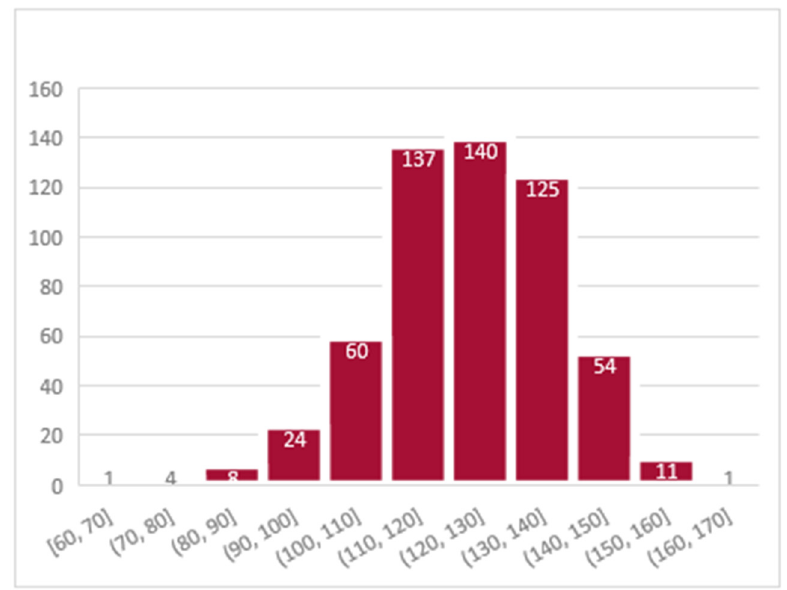
Figure 2. Frequency distribution of hemoglobin levels (N = 565). The histogram shows the distribu ‐ tion of the adjusted hemoglobin levels for the subsample of 565 women who participated in the survey of the family planning study in Malawi, completed the PHQ ‐ 9 Questionnaire, participated in blood testing, and had no missing values on the